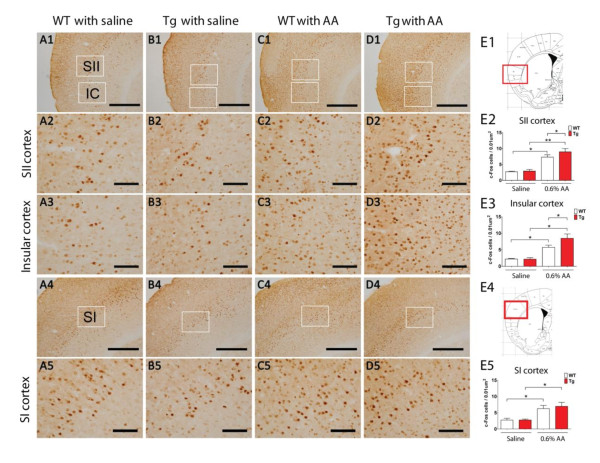
Induction of c-fos expression in forebrain cortex by 0.6% acetic acid stimulation. A-D. Representative photomicrographs of saline or acetic acid (i.p.) induced c-Fos expression in somatosensory SII cortex, insular cortex (IC) and SI cortex in wild type (WT) and transgenic (Tg) mice. The scale bar for panels A1-D1 and A4-D4 is 500 μm (low magnification), and the scale bar for A2-D2, A3-D3 and A5-D5 is 100 μm (high magnification). E1, Brain map [52] with photographed somatosensory SII and insular cortex framed in red. E2-3, Density of c-Fos positive cells in somatosensory SII cortex (E2) and Insular cortex (E3) of WT and Tg mice treated with saline or 0.6% acetic acid (i.p.). E4, Brain map [52] with the SI cortex framed in red. E5, Density of c-Fos positive cells in the SI cortex from WT and Tg mice treated with saline or 0.6% acetic acid (i.p.).Data are presented as mean ± s.e.m (n = 3-4, *p < 0.05, **p < 0.01).